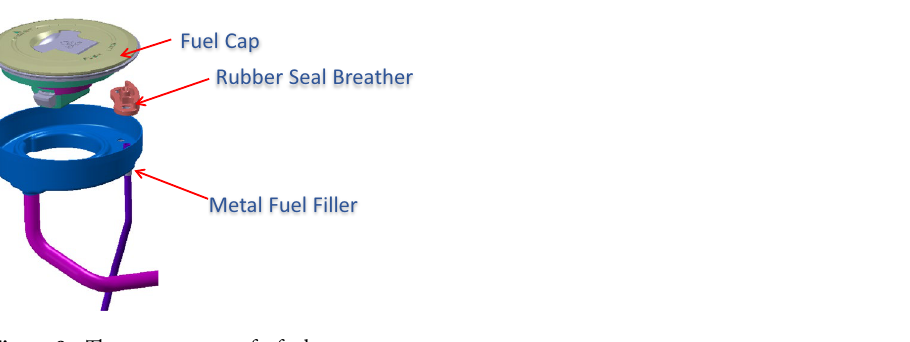
Figure 8. The components of a fuel